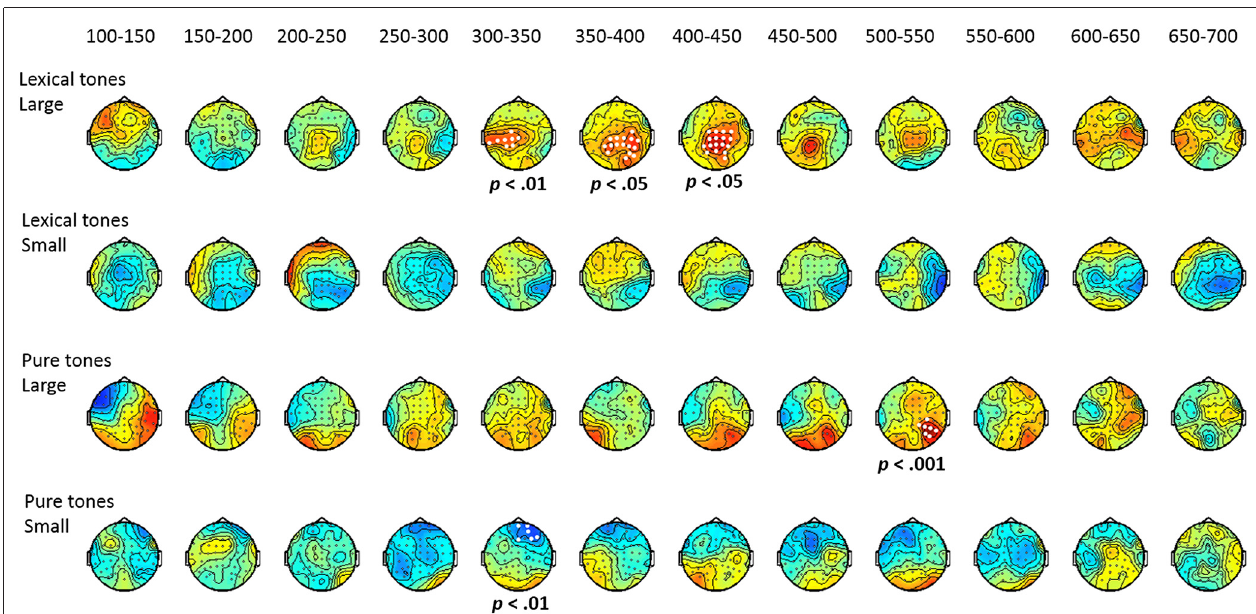
FIGURE 4 | Topographic maps of the group effect (control minus ADHD), based on cluster-based permutation analysis.